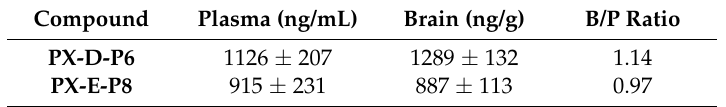
Table 3. Plasma and brain assays for PX-D-P6 and PX-E-P8 at 1 h after i.p. 50 mg/kg dose in rats ( n = 6).